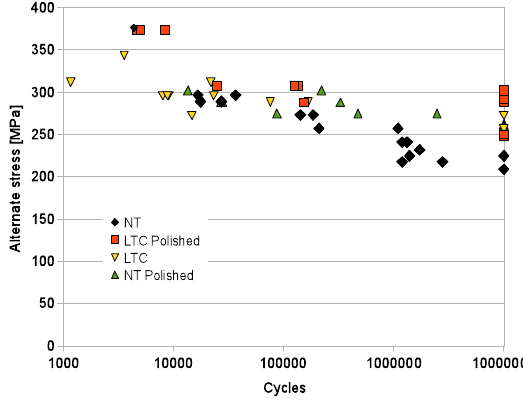
Fig. 3: Effect of the surface roughness on the fatigue